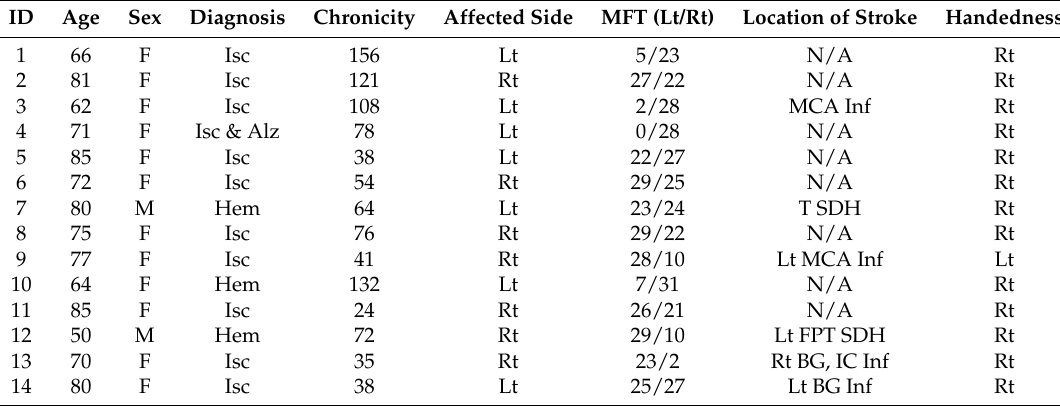
Table A3. Patient demographic information for the experimental group.